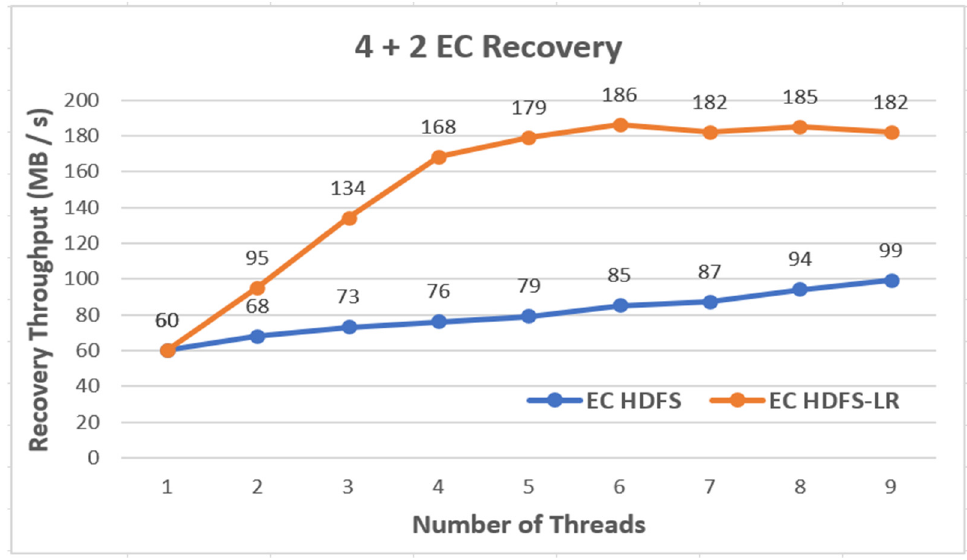
Figure 21. Difference in storage time according to file size.